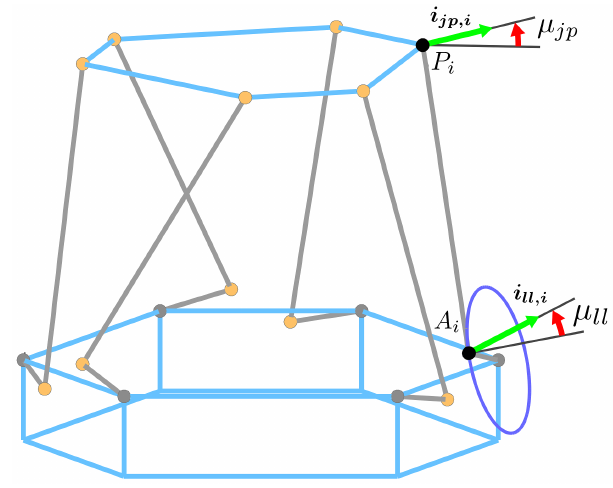
Figure 9. Axes of spherical joints.